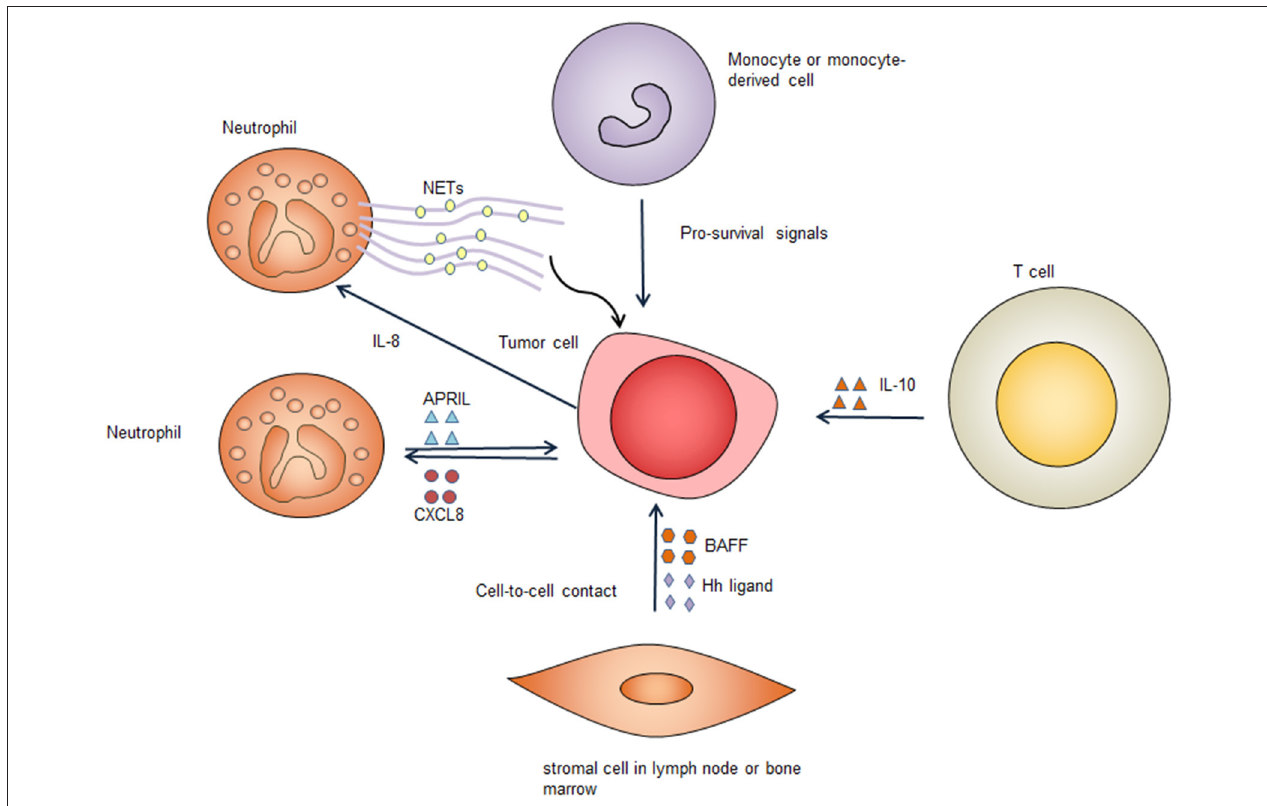
FIGURE 3 | Survival signals from the tumor microenvironment. Immune cells and stromal cells promote tumor cell survival through cell-to-cell contact and secreting pro-survival factors. Several types of cells in the tumor microenvironment secret pro-survival factors including B-cell activating factor (BAFF), a proliferation-inducing ligand (APRIL), hedgehog (Hh) ligands, and interleukin-10 (IL-10). These factors bind to corresponding receptors on the tumor cell surface, providing important pro-survival signals to the tumor cells. Neutrophils form neutrophil extracellular traps (NETs), which activate Toll-like receptor 9 (TLR9) pathway to promote survival of diffuse large B cell tumor cells. CXCL8, C-X-C motif chemokine ligand 8; IL-8,